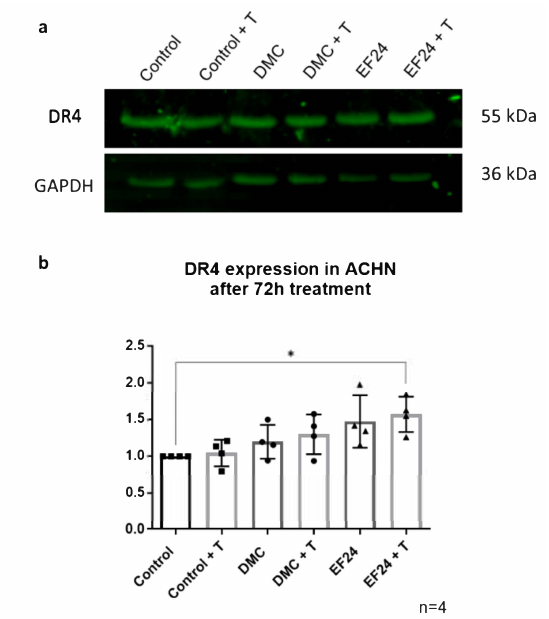
Figure 4. DR4 expression in ACHN after 72 dh treatment with the IC 10 concentrations of DMC